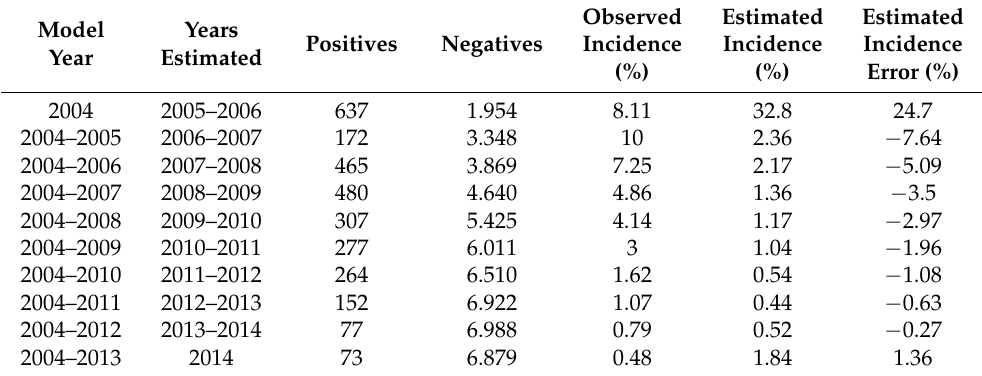
Table 4. Incidences of VZV infections observed in Pedianet and estimated by the model trained. Model Years Positives Negatives Year Estimated